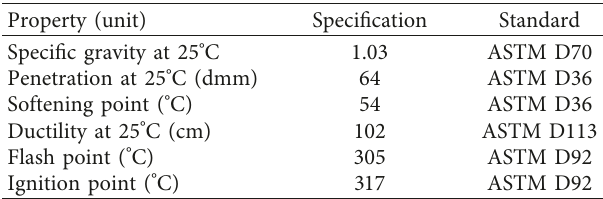
Table 1: Physical properties of base binder.